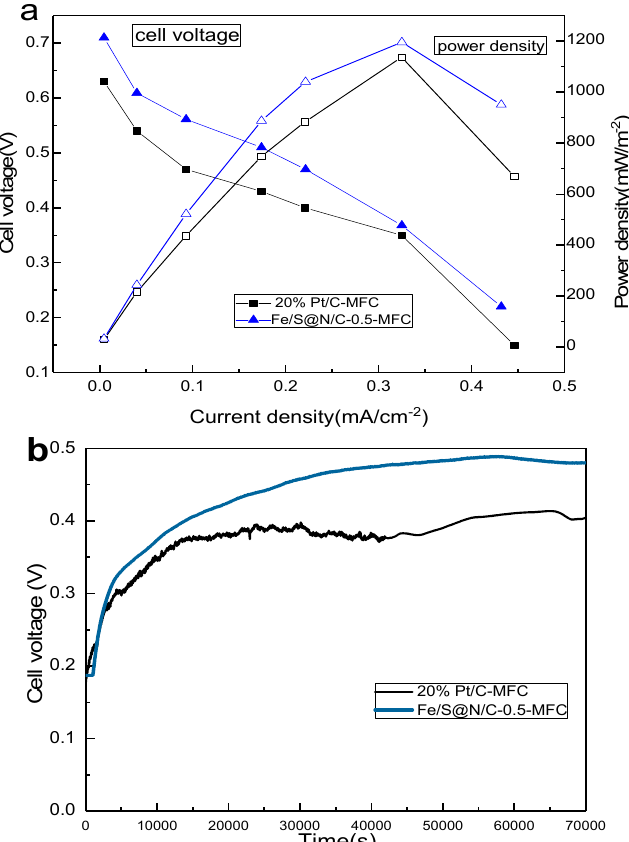
Figure 5. ( a ) Overall MFC polarization curves and power curves for the 20% Pt/C catalyst and Fe/S@N/C-0.5 catalyst. ( b ) Comparisons of output voltage in the operation of 20% Pt/C-MFC and Fe / S@N / C-0.5 catalyst. ( b ) Comparisons of output voltage in the operation of 20% Pt / C-MFC and Fe/S@N/C-0.5-MFC. Fe / S@N /